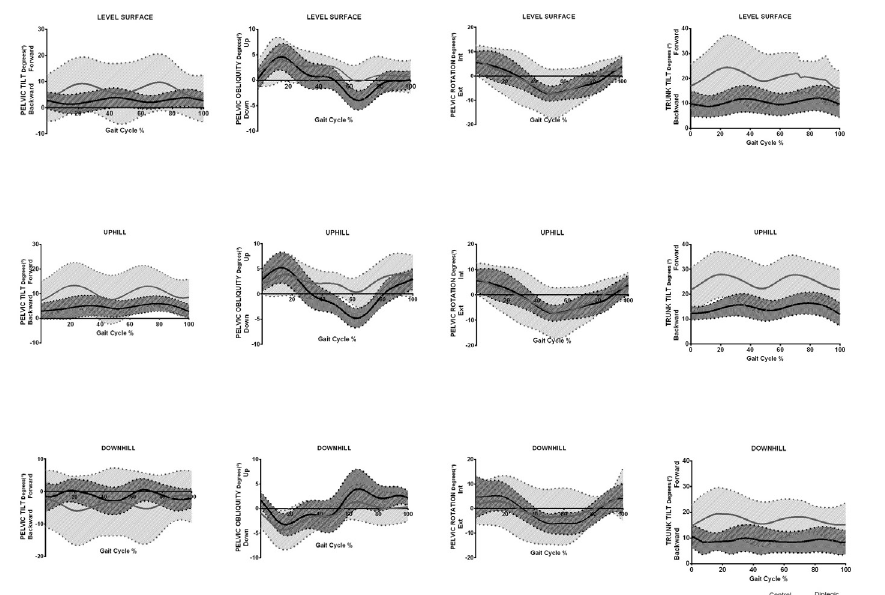
Figure 3 - Evolution of the angular variables of the pelvis and trunk Control Group and Diplegic Group over time, the horizontal, ascending and descending